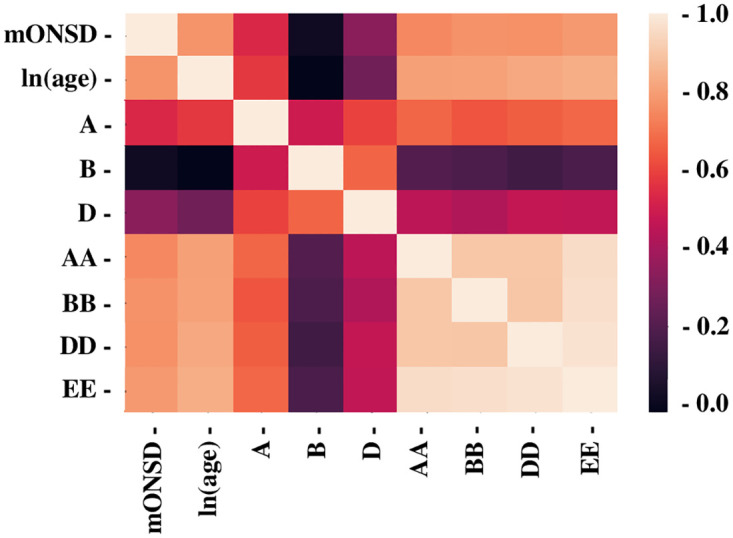
Heatmap of the multivariate analysis results.The correlation coefficient was expressed in heatmap fashion. Lower coefficient was shown in darker, higher in lighter. mONSD; mean optic nerve sheath diameter, A: Maximum distance between anterior horn, B: Minimum bicaudate nuclei distance, D: Third ventricle distance. AA, BB and DD: corresponding brain width to A, B and D, respectively, EE: a square root of summation for AA2, BB2, and DD2.